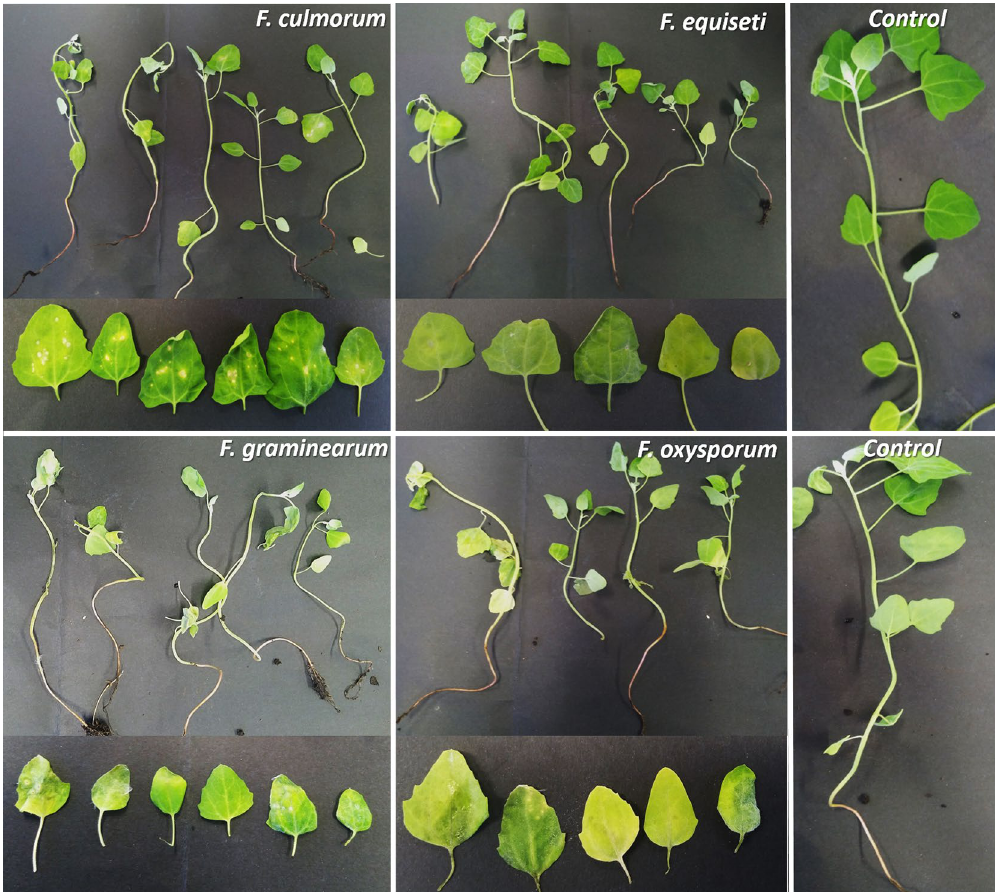
Figure 6. Symptomatology induced by F. culmorum , F. equiseti , F. graminearum and F. oxysporum in Piartal cv seedlings inoculated by brush method. The symptomatology is observed on the plant (above) and its